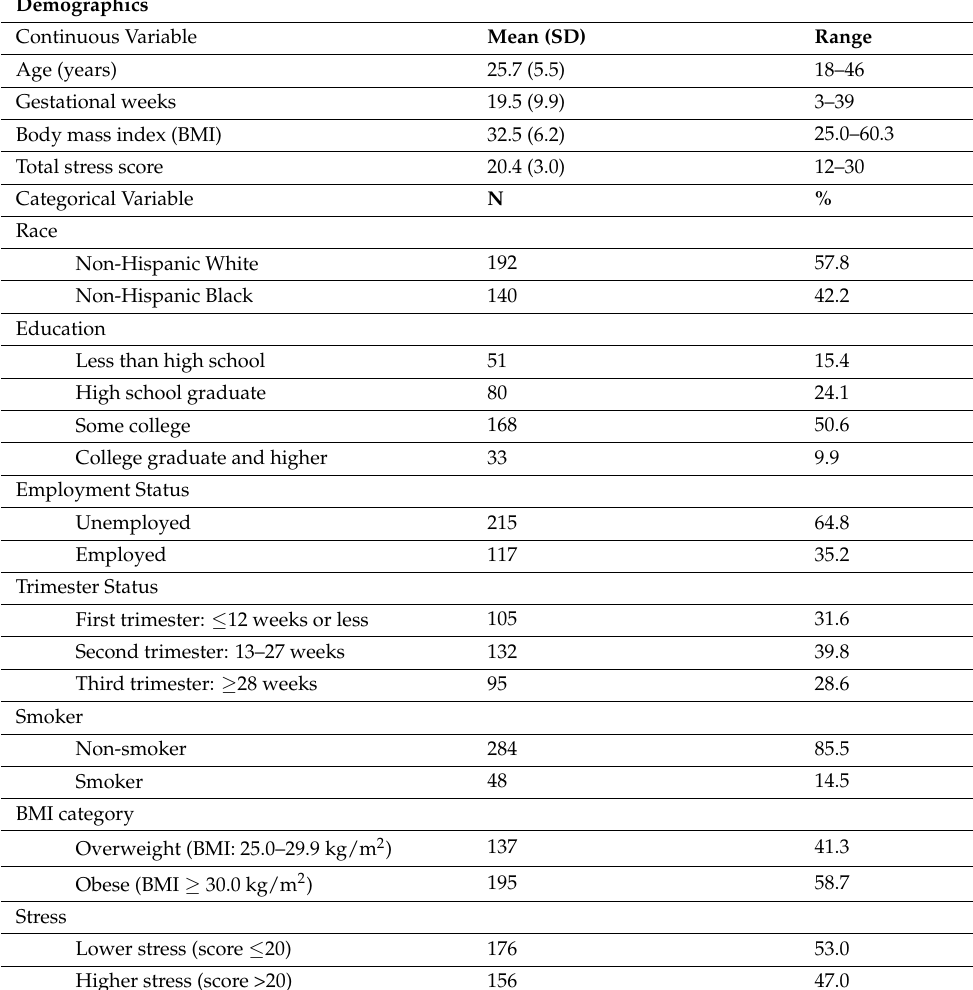
Table 1. Demographics of low-income overweight or obese pregnant women (N = 332).